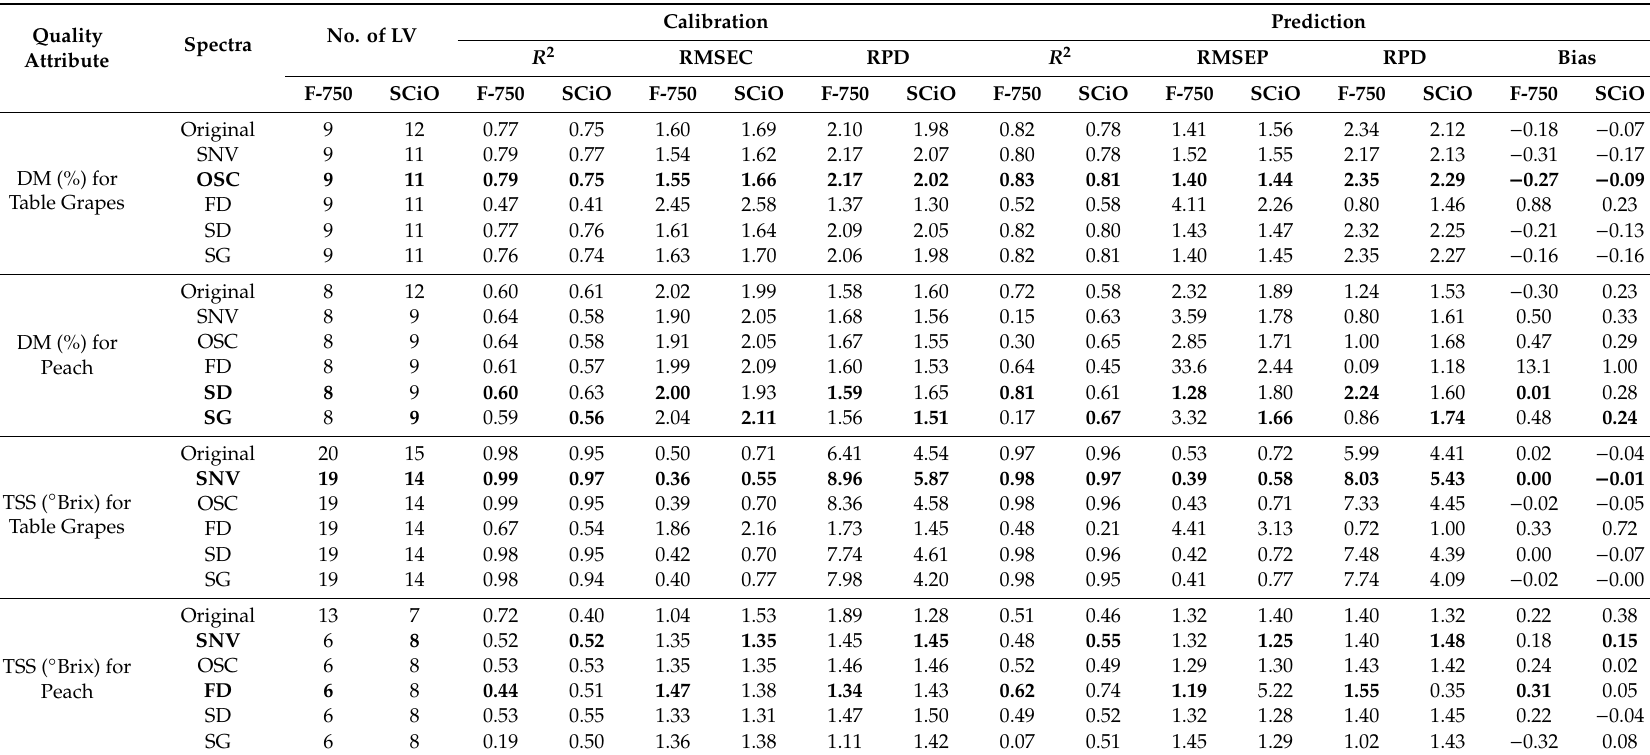
Table 3. Partial least-square regression calibration and prediction model results for table grape and peach quality